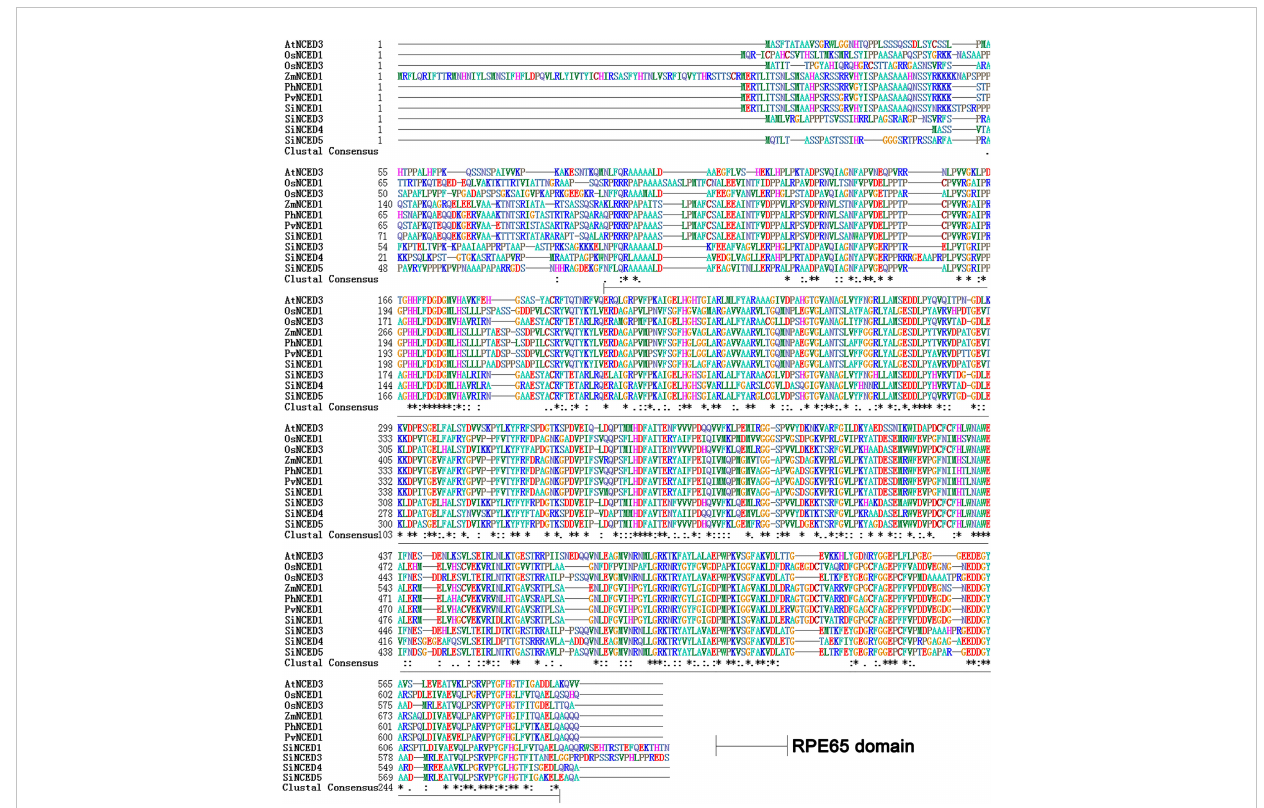
FIGURE 2 Multiple alignment of the deduced protein sequence of SiNCED1 and NCED proteins from other plants. Ten protein sequences from six species were selected and analyzed by